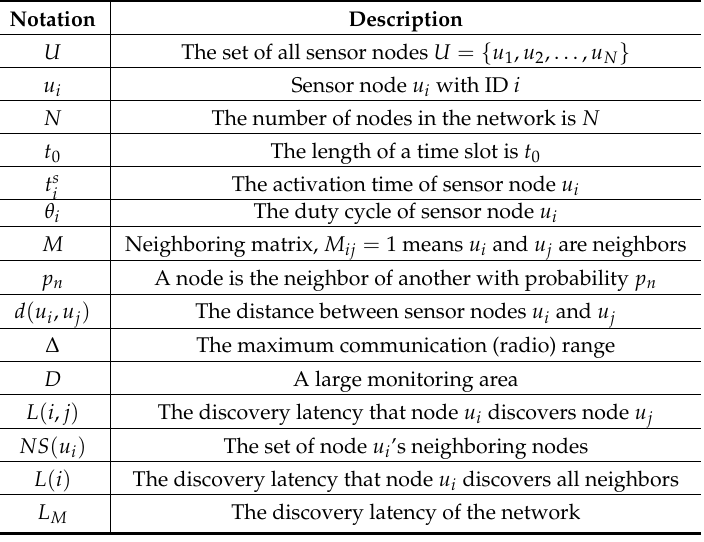
Table 1. Notations for neighbor